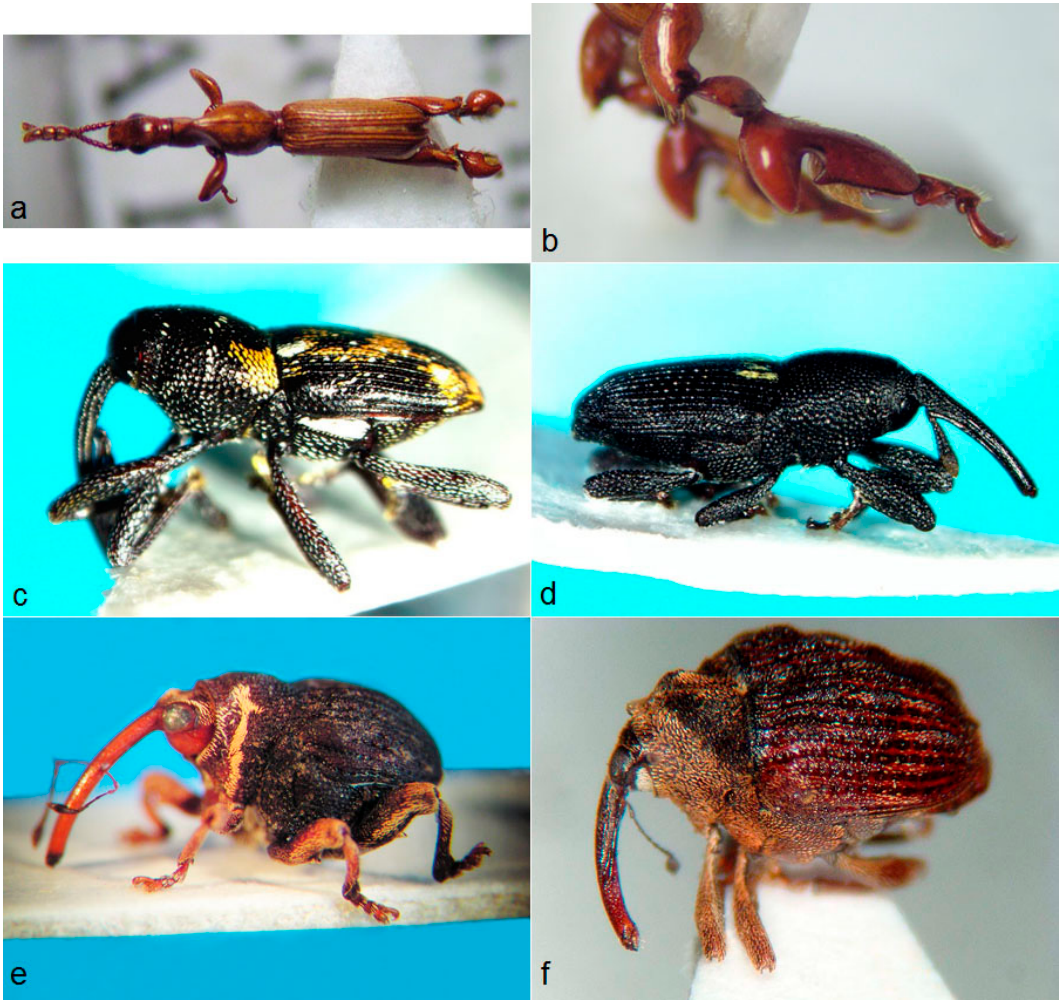
Figure 3. Adult ( a ) and conspicuous hind tibiae ( b ) of Calodromus insignis (Brentidae), Centrinertus spec. ( c ); Nespilobaris sp. (both Baridinae) ( d ); Watanabesazuro sp. (Mecysmoderini) ( e ); and Megahypurus sp. from the tribe Egriini (both Ceutorhynchinae) ( f